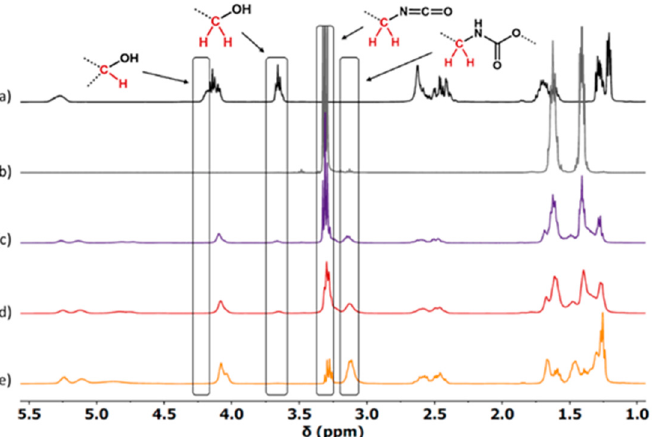
Figure 1. 1 H-NMR Spectra for OligoPHB-diols and the different PUPs. From top to bottom: ( a ) oligoPHB-diol, ( b ) HDI, ( c ) PUP6-1, ( d ) PUP4-1 and ( e ) PUP2-1. Main functions and hydrogens are depicted on top of the figure, and corresponding changes in the spectra are circled.